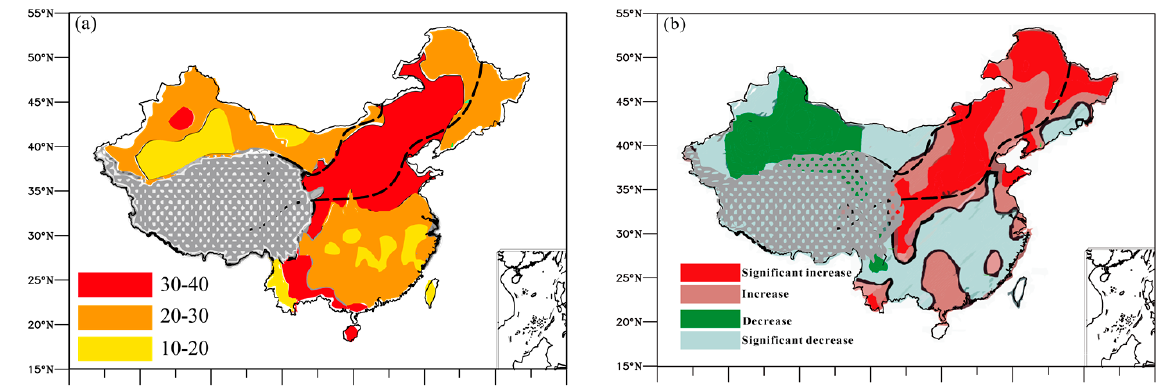
Figure 2. The drought frequency ( a ) and drought trend ( b ) in NDPB. The spatial patterns of drought frequency (that is, days of drought) is modified from [33] , and the trend of drought is modified from [34].